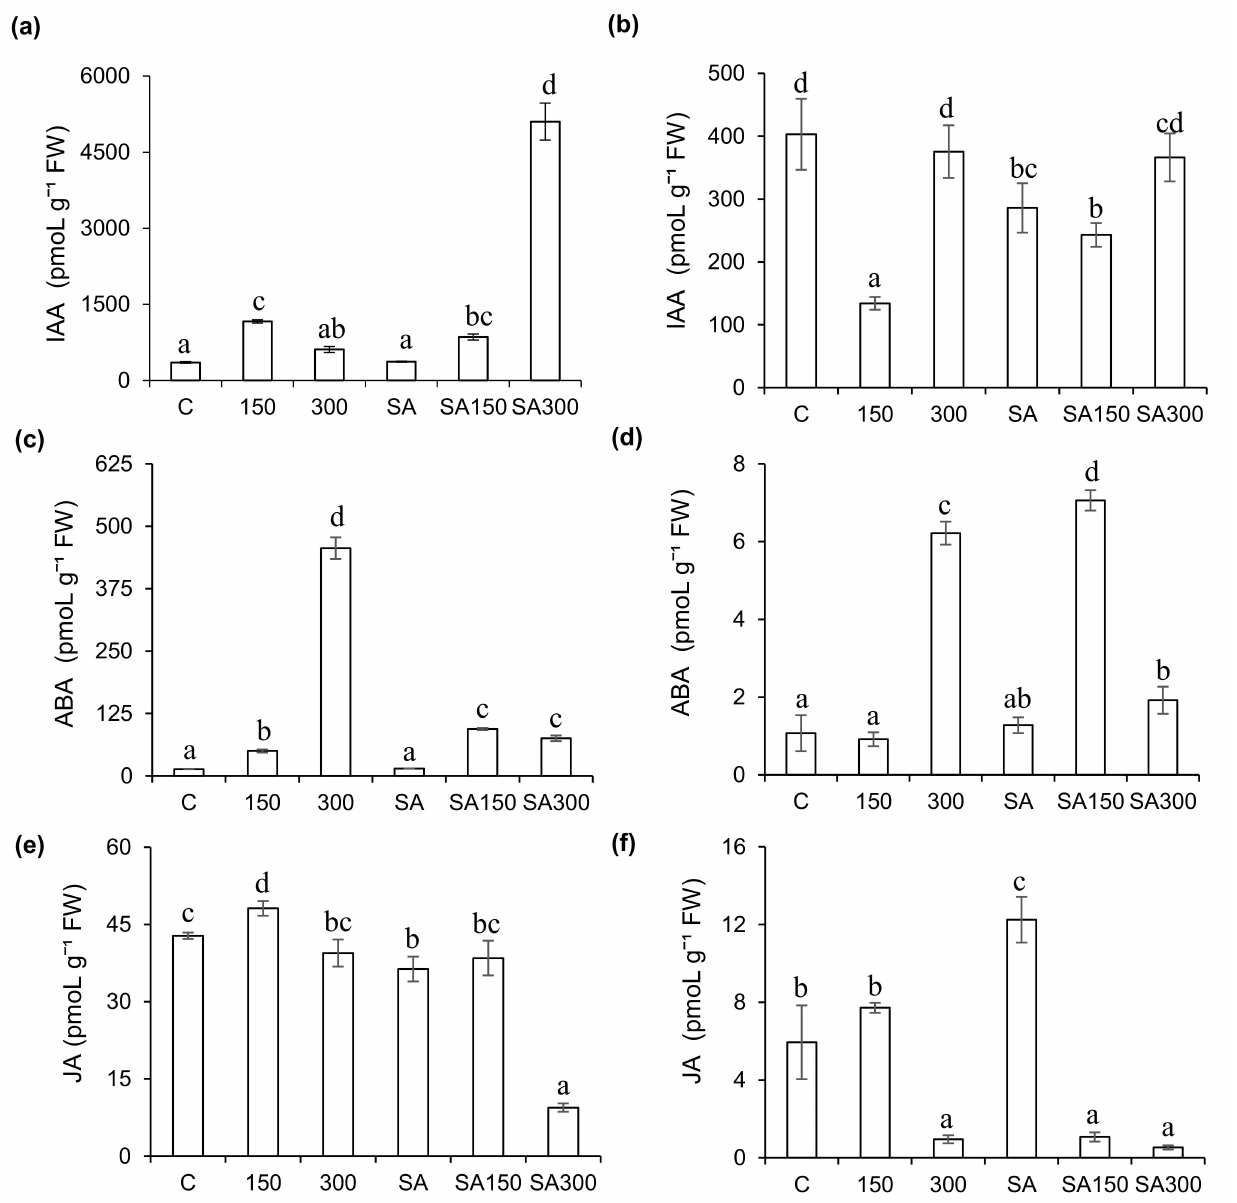
Figure 3. Effect of salicylic acid (SA) pre-treatment on indol-3-acetic acid (IAA), abscisic acid (ABA), and jasmonic acid (JA) levels of Hordeum vulgare L. ‘Ince-04 (cid:48) plants leaves. Leaves ( a , c , e ) and roots ( b , d , f ) under control and saline conditions (150 and 300 mM NaCl). Different letters indicate significant differences between treatments ( p <